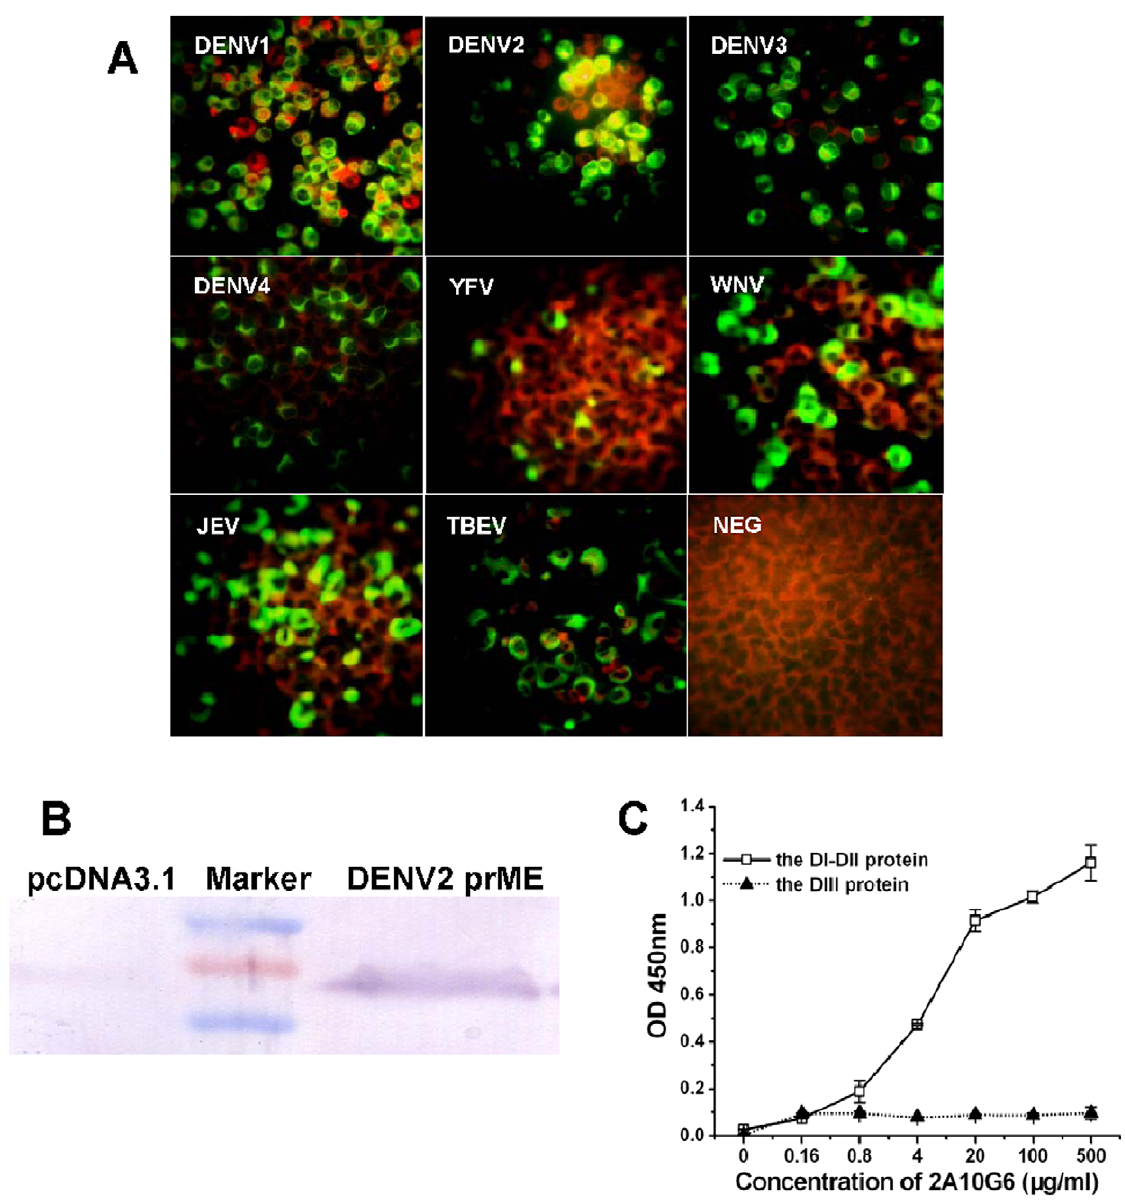
Figure 1. Characterization of mAb 2A10G6 invitro . A. Cross-reactivity of 2A10G6 with four DENV serotypes and four other representative flaviviruses determined by indirect immunofluorescence analysis. BHK21 cells were infected separately with DENV1–4, YFV, WNV, JEV, or TBEV. Three to 5 days after infection, cells were fixed and analyzed by IFA with 2A10G6. Uninfected cells were run simultaneously as negative controls. B. The specificity of 2A10G6 for the DENV2 prME protein. BHK21 cells were transiently transfected with the recombinant plasmid encoding the prME protein or with a control vector, empty pcDNA3.1. At 48 h after transfection, cultured cells were lysed and analyzed by western blotting with 2A10G6. C. The specificity of 2A10G6 for the DENV2 DI–DII peptide. The DENV2 DI–DII peptide was expressed in E. coli as a fusion protein with thioredoxin, and binding of different concentrations of 2A10G6 with DENV2 antigen and recombinant DI–DII peptide was detected by ELISA.